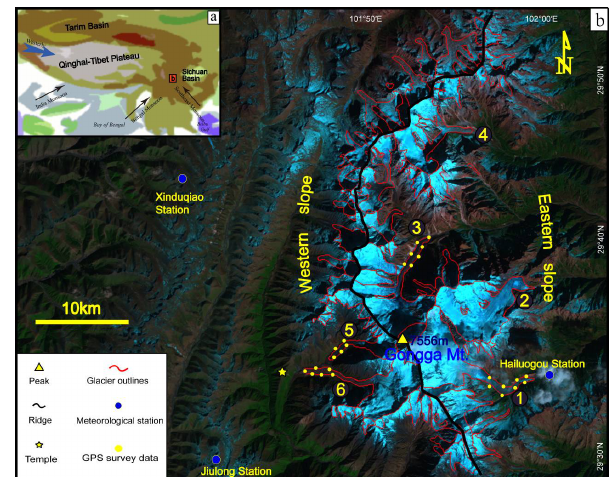
Fig.1. The location of Gongga Mountains (a) Showing the location of the Study region; Jiulong and Xinduqiao meteorological stations; (b) Glacier extent in Study region with Landsat TM band 743 (as RGB): NO.1 Hailuogou Glacier, NO.2Mozigou Glacier, NO.3Yanzigou Glacier, NO.4Nanmenguangou Glacier, NO.5Xiaogongba Glacier and NO.6Dagongba Glacier. Yellow point is a sketch about GPS data.